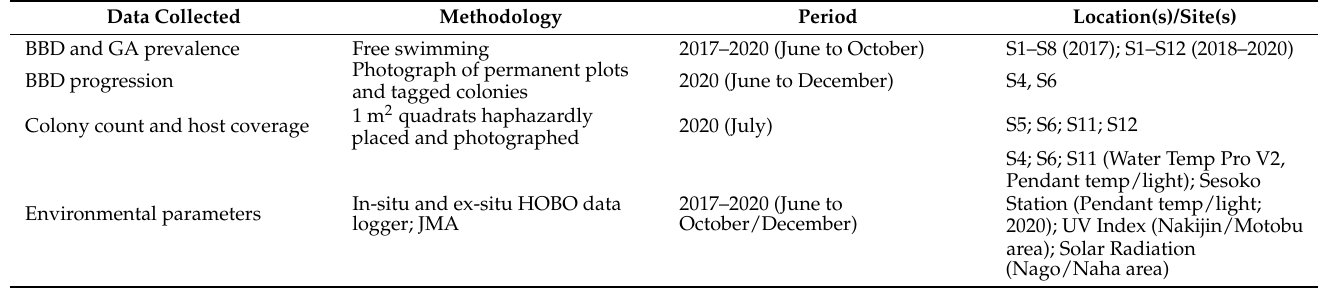
Table 2. Summary of different types of data collected in this study with respective locations and time.